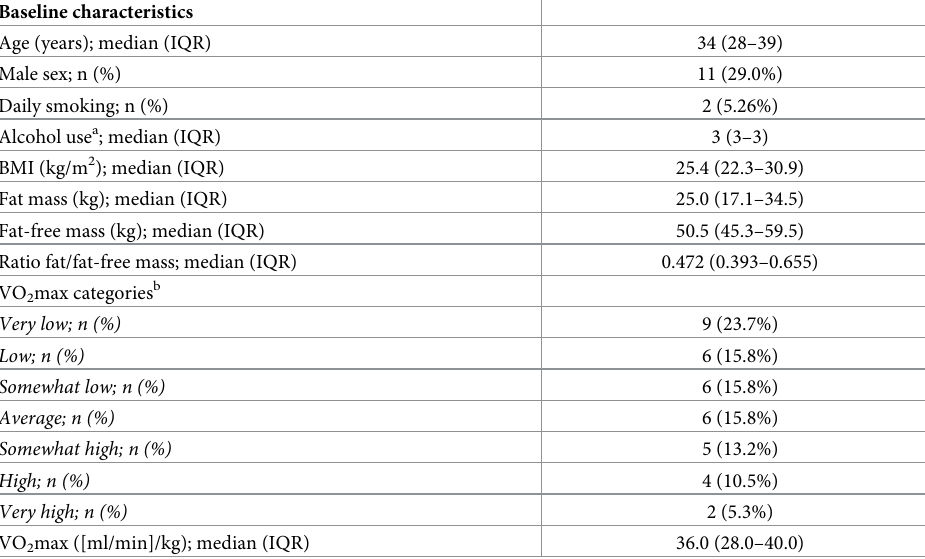
Table 1. Baseline characteristics of the study participants with mobility disability (N = 38). Baseline